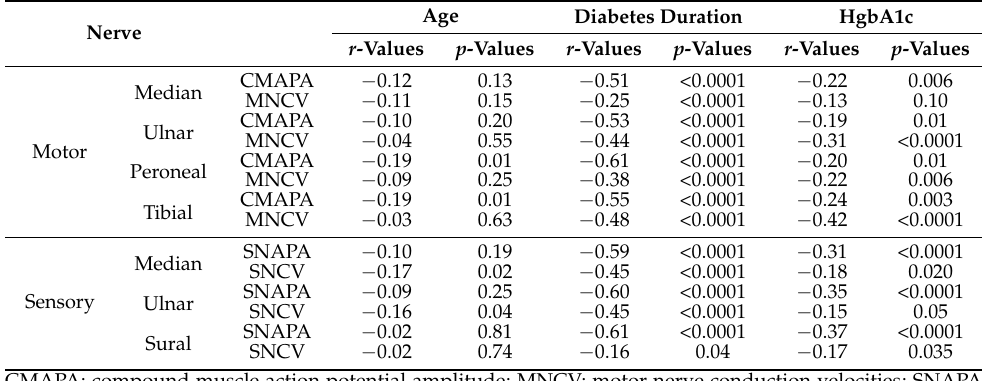
Table 5. Results of correlations between the electrophysiological parameters of both motor and sensory nerve function and clinical and demographic selected